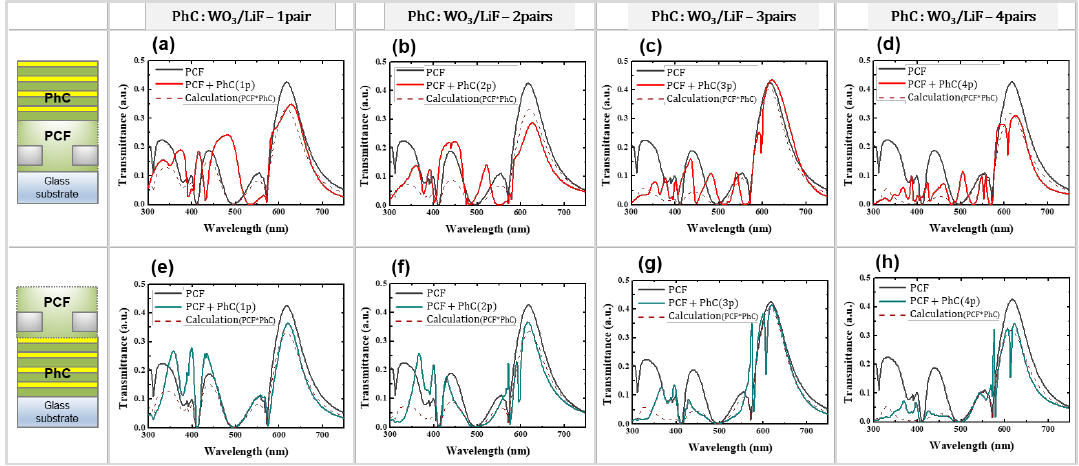
Figure 4. Transmission spectra of PCFs combined with 1D-PhCs (WO 3 and LiF). ( a – d ) show the results for glass/PCF/PhC structures, and ( e – h ) show the results for glass/PhC/PCF structures. In all graphs, the dashed lines represent the product of PhC effects (in Figure 3) and the transmittance of the reference PCF.